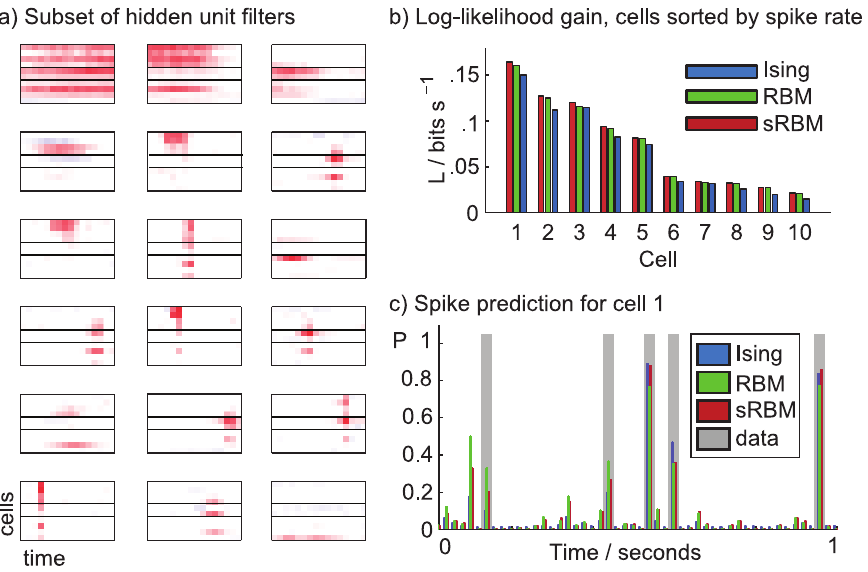
Figure 6. Spatiotemporal network models. ( a ) Hidden units of spatiotemporal sRBM model. For each hidden unit, the horizontal axis is time and the vertical axis cells with horizontal bars separating the subgranular, granular and supergranular cortical layers. ( b ) Log-likelihood gain for each of the 10 cells (ordered by firing rate) conditioned on the remainder of the network state for all three models. ( c ) Spike prediction from network history. For one of the cells, we show 1 s of predicted activity given the history of the network state. In each case when a spike occurs in the data (gray bars), there is an elevated probability under the models (colored bars).